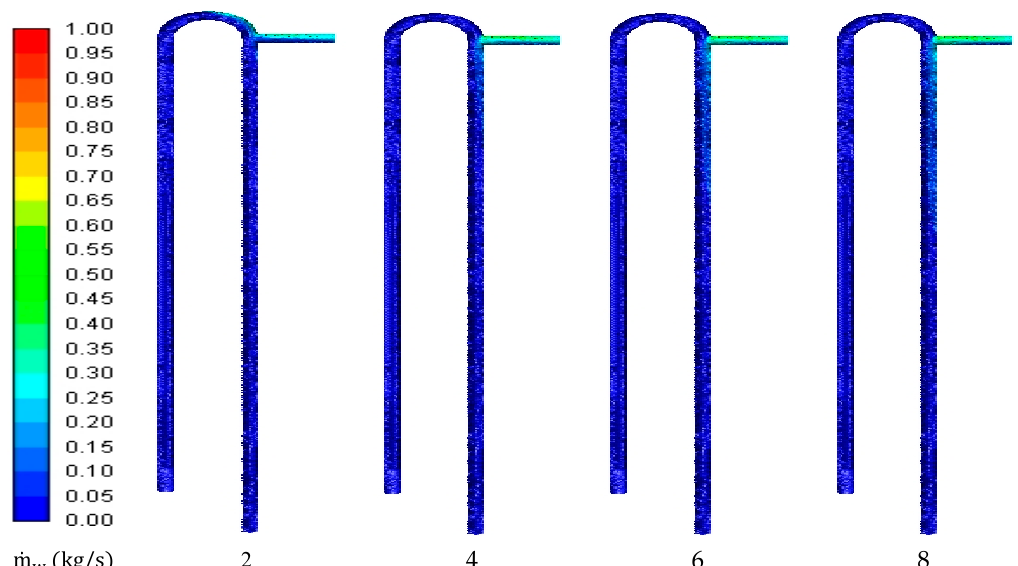
Figure 17. Air volume fraction contours at di ff erent flow ratios and X w = 6187.64, α m = 0.2 and X v = 0.5.